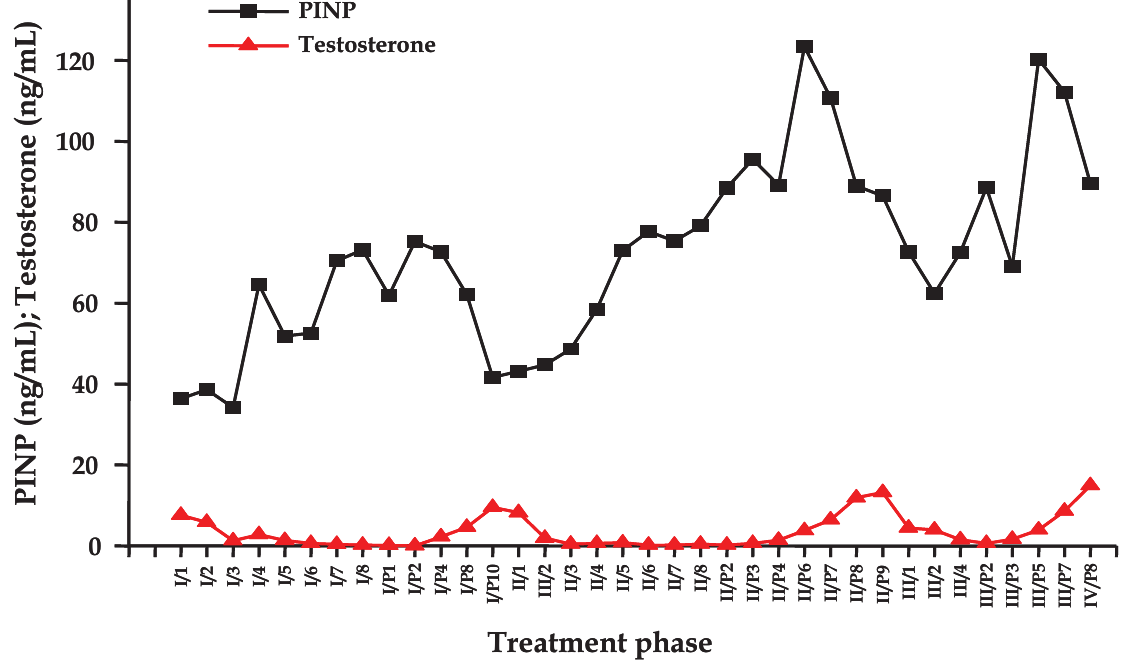
Figure 1. Time courses of testosterone and PINP levels during three IAS cycles in a prostate cancer patient. I – III indicate the three AS and I/P – III/P the treatment cessation periods, with arabic characters denoting the respective month of